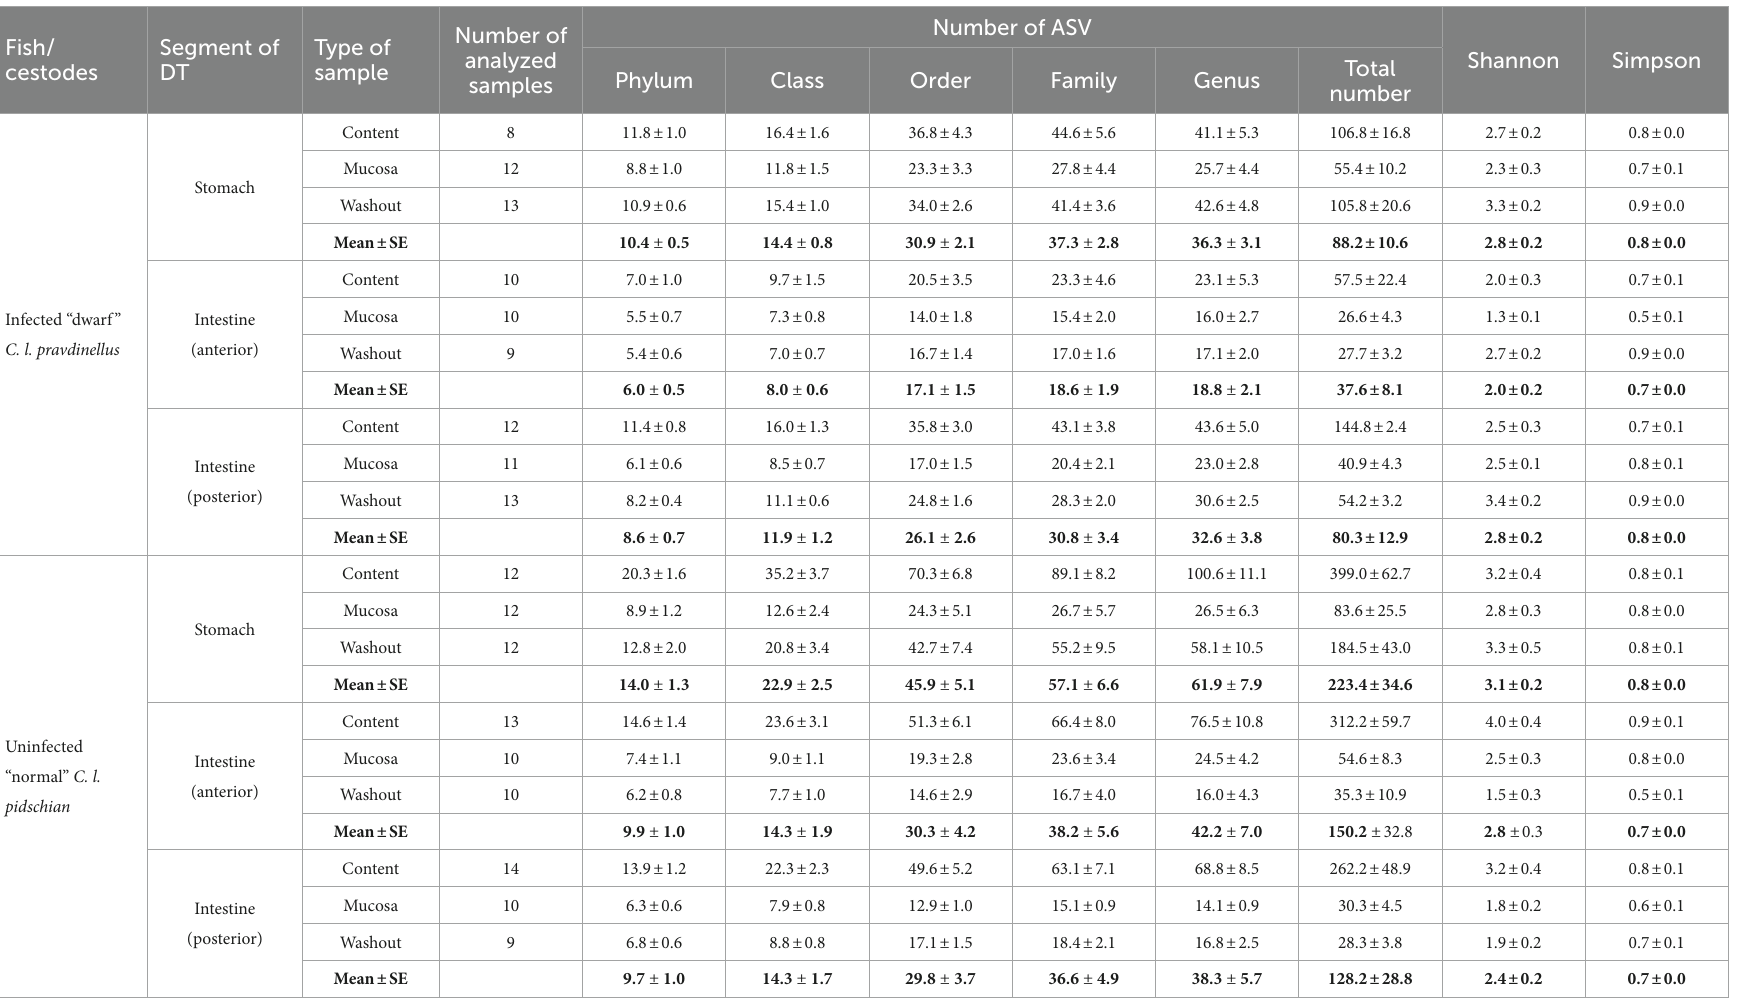
TABLE 1 Metrics of diversity estimates of the microbial community associated with different parts of the digestive tract (DT) of whitefish and cestodes parasitizing the intestine of C. l. pidschian